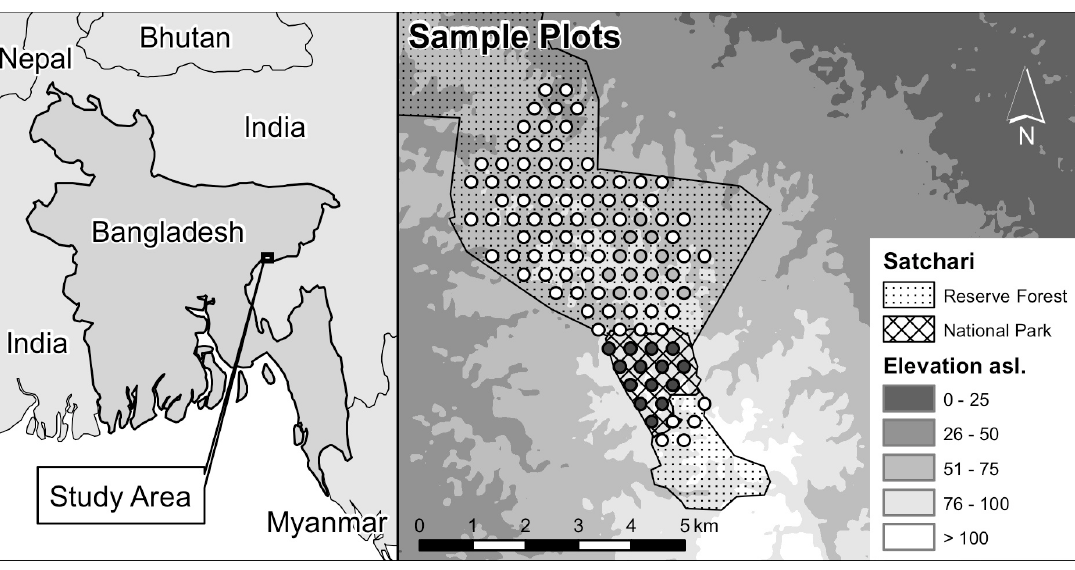
Figure 2. The study area in east Bangladesh covers the core area of Satchari National Park (15 plots) and the forested parts of Satchari Reserve Forest (96 plot). Two sub samples from Satchari National Park (black circles) and Satchari Reserve Forest (grey circles) were compared in the distance-decay